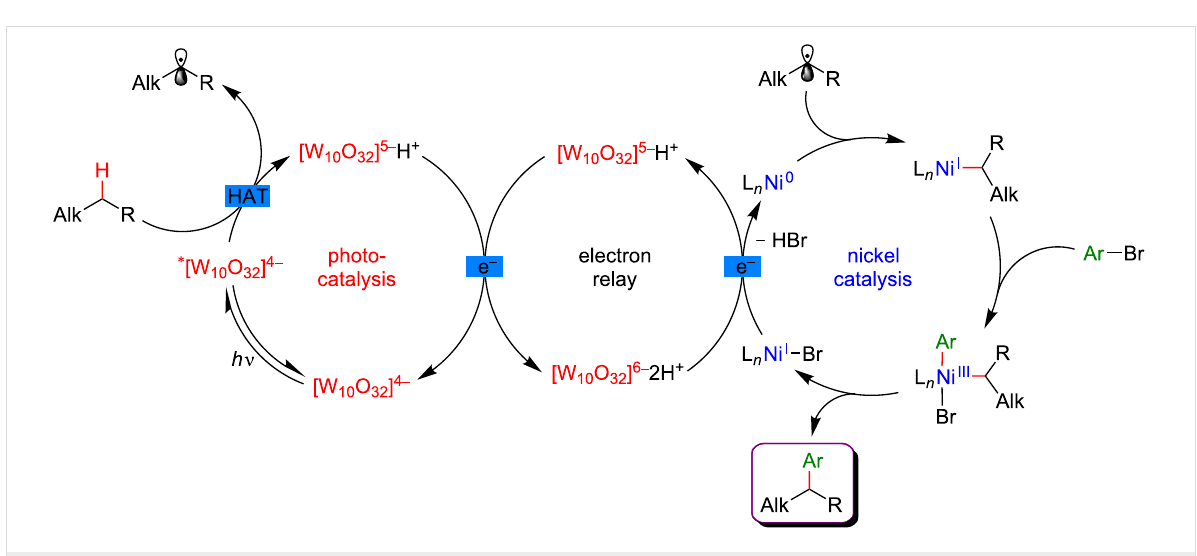
Figure 78: Proposed mechanism for the C–H arylation of strong aliphatic bonds promoted by HAT.